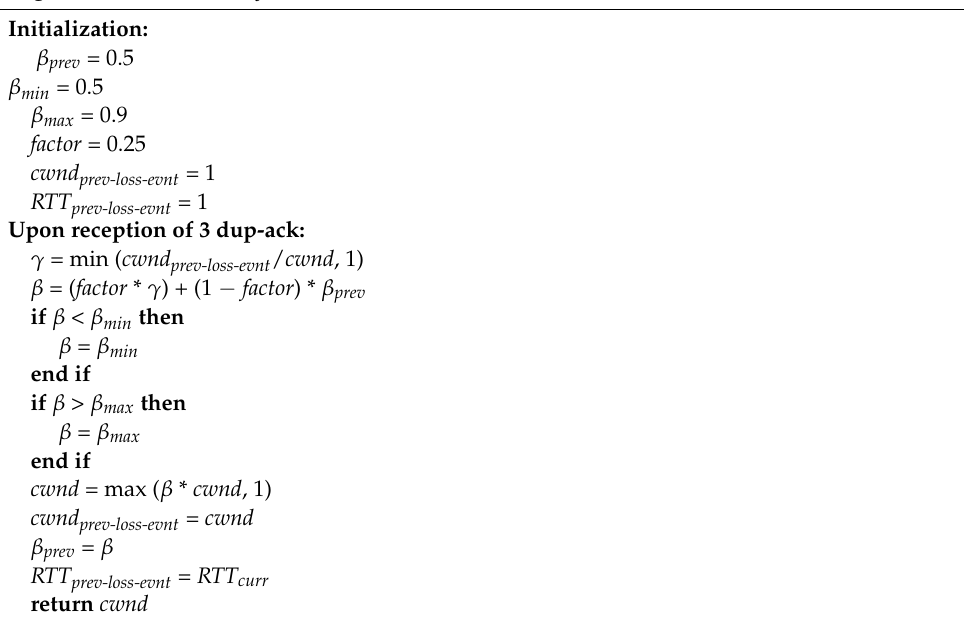
Algorithm 2: CWND—Dynamic Decrease